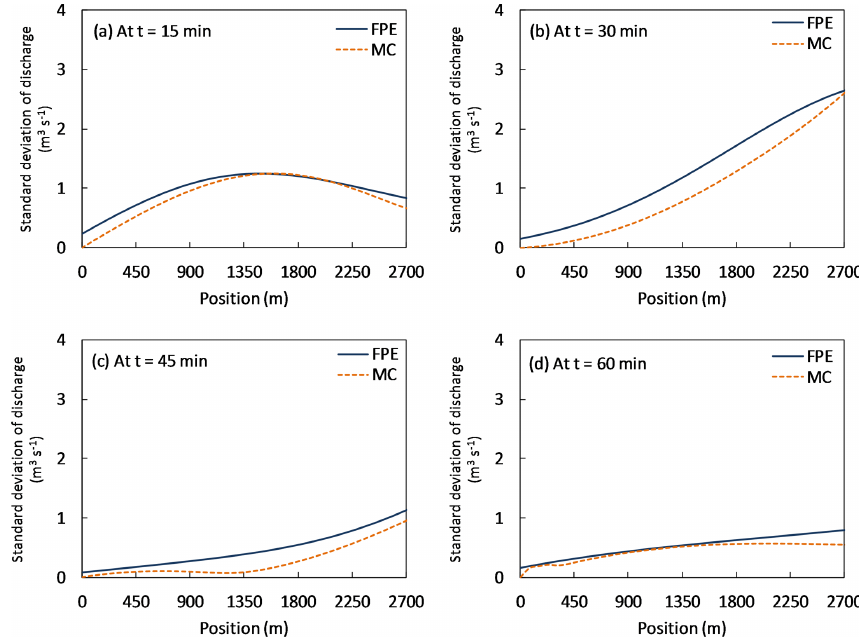
Figure 9. Comparison of the standard deviation of the flow discharge obtained by the FPE methodology and the MC approach as a function of channel location, at different